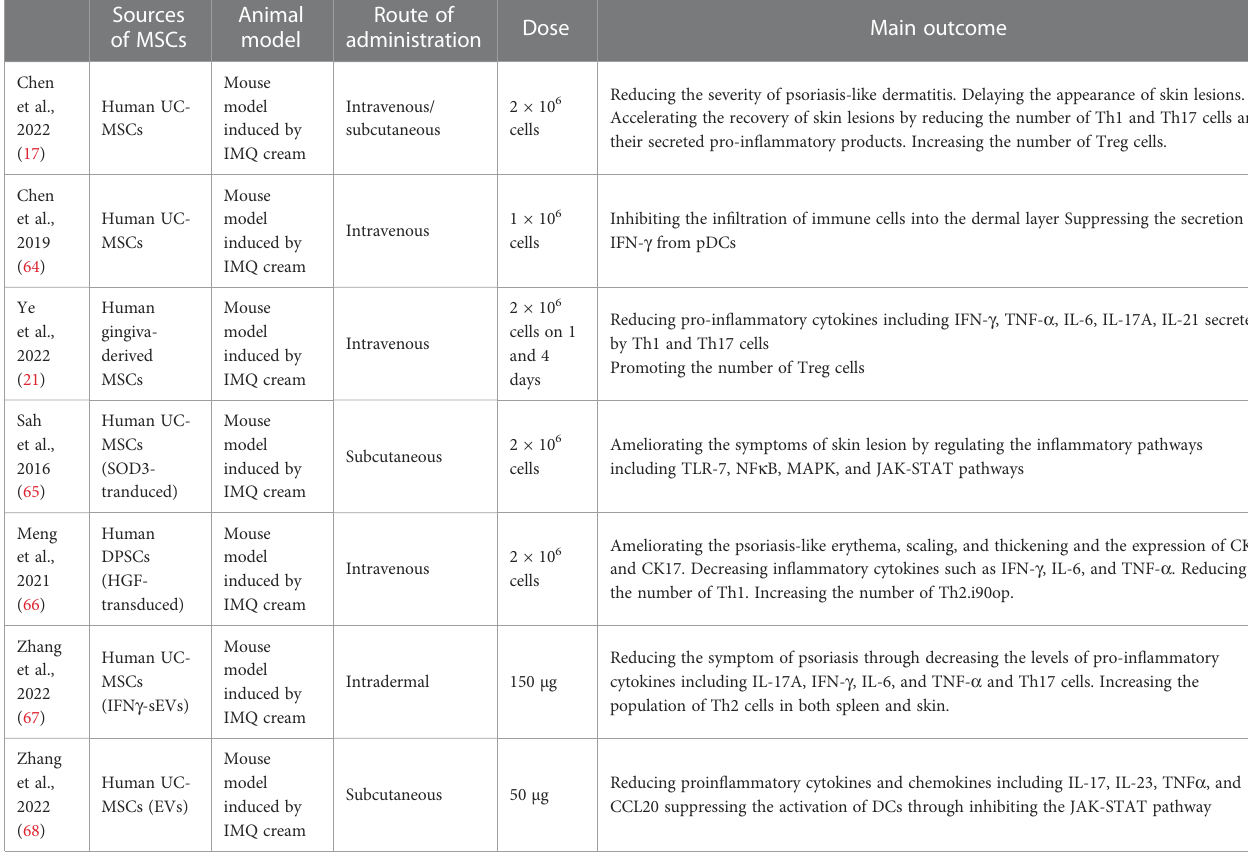
TABLE 2 The therapeutic effects of MSCs and their derivatives from different sources in